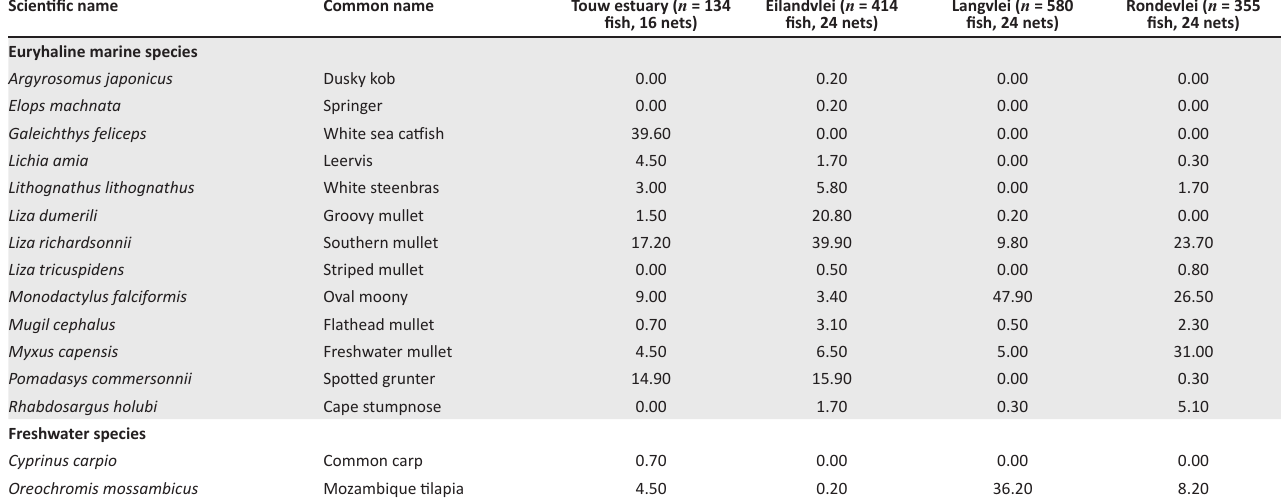
TABLE 3: Relative abundance ( % abundance) of fish species caught in gill nets in the Wilderness Lakes System between April 2010 and January 2011. Scientific